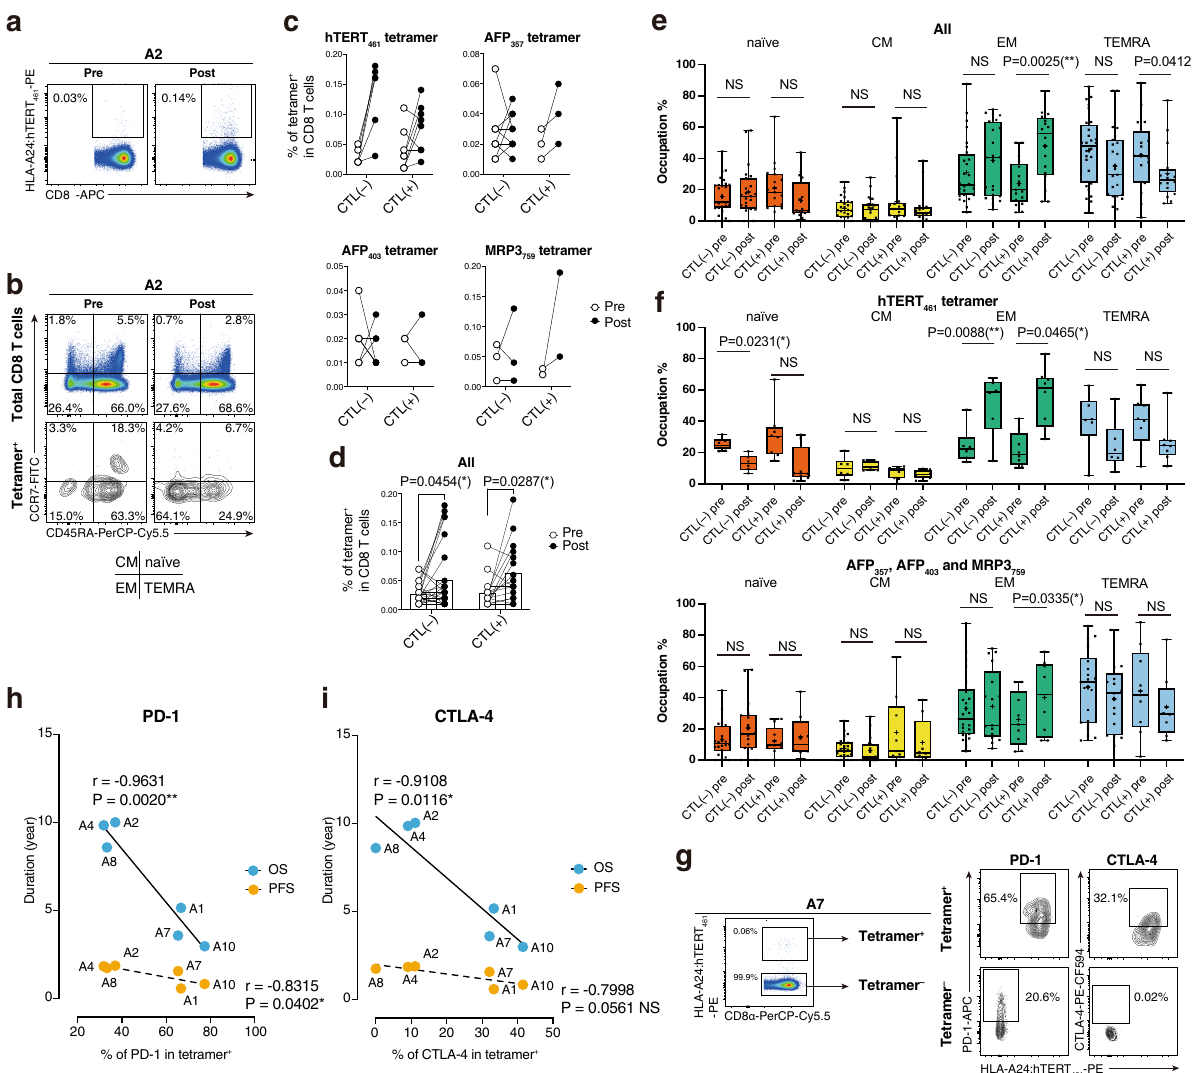
Fig. 2 Induction of HLA-A24:peptide tetramer-binding T cells and phenotypic features. A representative example of fl ow plots is shown. The frequency of the CD8 α + tetramer + fraction was calculated ( a ). Both total CD8 + T cells and tetramer + CD8 + T cells were detected by CD45RA and CCR7. Four fractions of naïve, central memory (CM), effector memory (EM), and terminally differentiated effector memory with CD45RA (TEMRA) are shown ( b ). Tetramer positivity among CD8 + T cells was compared between pre and postvaccination in CTL( − ) and CTL( + ) of each vaccine study. Samples from the same donors are connected by solid lines. c . The results were combined in one graph. Samples from the same donors and tetramers are connected by solid lines. Mean values are shown by open bars. Two-way repeated-measures ANOVA followed by Bonferroni and Sidak ’ s multiple comparison post hoc test was carried out. * P < 0.05. d Frequencies of naïve, CM, EM, and TEMRA fractions among tetramer + CD8 + T cells are displayed in box-and-whisker plots. CTL( − ) ( n = 26) and CTL( + ) ( n = 16) of pre and post are shown. Statistical analysis was conducted using two-way ANOVA followed by Bonferroni and Sidak ’ s multiple comparison test to assess differences in composition among the different conditions of CTL induction and treatments. * P < 0.05; ** P < 0.005; NS, not signi fi cant; error bar, maximum to minimum; horizontal lines of box, fi rst quartile to third quartile; + , mean value ( e ). The frequencies of naïve, CM, EM, and TEMRA fractions among tetramer + CD8 + T cells of the hTERT study ( n = 14) and the other three cohorts ( n = 28) were analyzed separately. Two-way ANOVA followed by Bonferroni and Sidak ’ s multiple comparison test was carried out. * P < 0.05; ** P < 0.005; NS, not signi fi cant; whiskers, maximum to minimum; horizontal lines of box, fi rst quartile to third quartile; + , mean value ( f ). Expression of inhibitory receptors PD-1 and CTLA-4 by HLA-A24:hTERT 461 tetramer-binding CD8 + T cells was assessed. g The percentages of PD-1/CTLA-4 expression and overall survival (OS) period/progression-free survival (PFS) were plotted, then liner regression lines were calculated. r, Pearson ’ s r; * P < 0.05; ** P < 0.005; NS, not signi fi cant ( h , i ) Source data are provided as a Source Data fi le. peptide-speci fi c T cell functions. Peptide-speci fi c TCRs were blood sample (Fig. 4a, Supplementary Table 4). We tested these analyzed in two patients: A2 from the hTERT peptide vaccine TCRs to con fi rm their Ag speci fi city and killing activities, which study and D3 from the AFP peptide vaccine study. These patients suggested that these TCRs played signi fi cant roles in controlling both survived for more than 10 years after vaccination and HCC development after peptide vaccination. hTERT-speci fi c exhibited the peptide-speci fi c T cell inductions. As reported TCRs had a target cell killing activity only if the targets were previously 13,14 , we identi fi ed three hTERT 461 -speci fi c TCRs in A2 loaded with the hTERT 461 peptide (Fig. 4b). AFP-speci fi c TCRs and three AFP 357 -speci fi c TCRs of D3 in the 1-year peripheral were evaluated in the same peptide-loaded cytotoxicity assay NATURE COMMUNICATIONS| (2022) 13:3123